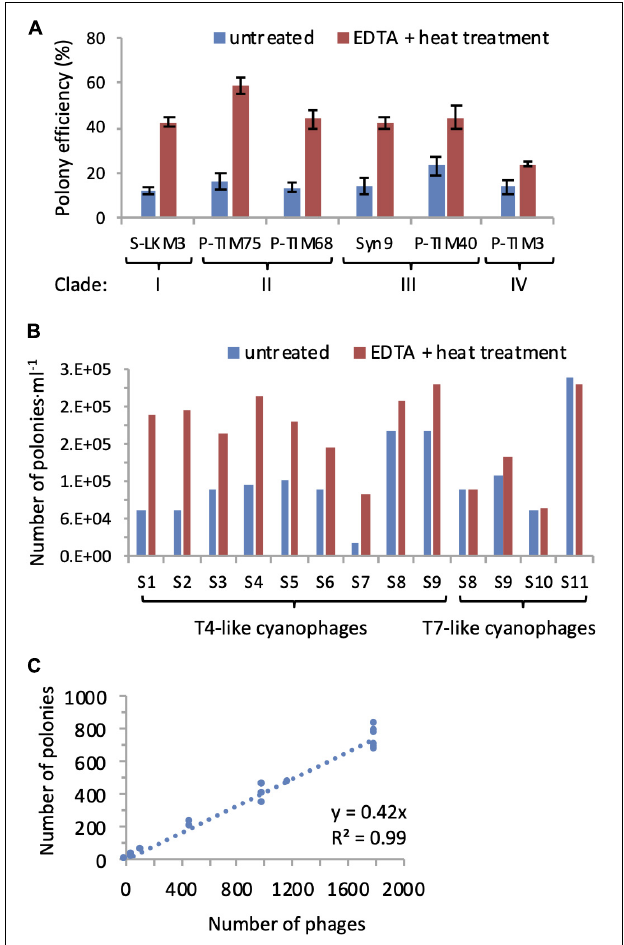
FIGURE 3 | EDTA-heat treatment increases efficiency of polony formation for T4-like cyanophages. (A) Polony formation efficiencies determined for cyanophages from all four clades of T4-like cyanophages with and without EDTA-heat treatment. Averages and standard deviations of 5 replicate treatments are shown for each cyanophage. A significant improvement in polony formation efficiency resulted from EDTA-heat treatment for each T4-like cyanophage (two-sample two-tailed t -test: p = 3.5E-11 for S-LKM3, p = 2.5E-08 for P-TIM75, p = 2.4E-08 for P-TIM68, p = 2.0E-07 for Syn9, p = 8.1E-06 for P-TIM40; non-parametric Mann–Whitney U Test: p = 0.00804 for P-TIM3). (B) The number of T4-like and T7-like cyanophages detected by polonies with and without EDTA-heat treatment for samples collected from the Red Sea (samples 1–6), Mediterranean Sea (sample 7), and the North Pacific Ocean (samples 8–11). Averages of two replicates assays are shown for each sample. EDTA-heat treatment significantly increased the number of T4-like cyanophages detected by the polony assay ( p = 9.4E-05, two-tailed paired t -test), but had no effect on the number of T7-like cyanophages detected ( p = 0.519, two-tailed t -test). (C) Standard curve of polony formation for the T4-like cyanophage, Syn9, after EDTA-heat treatment ( n = 19).